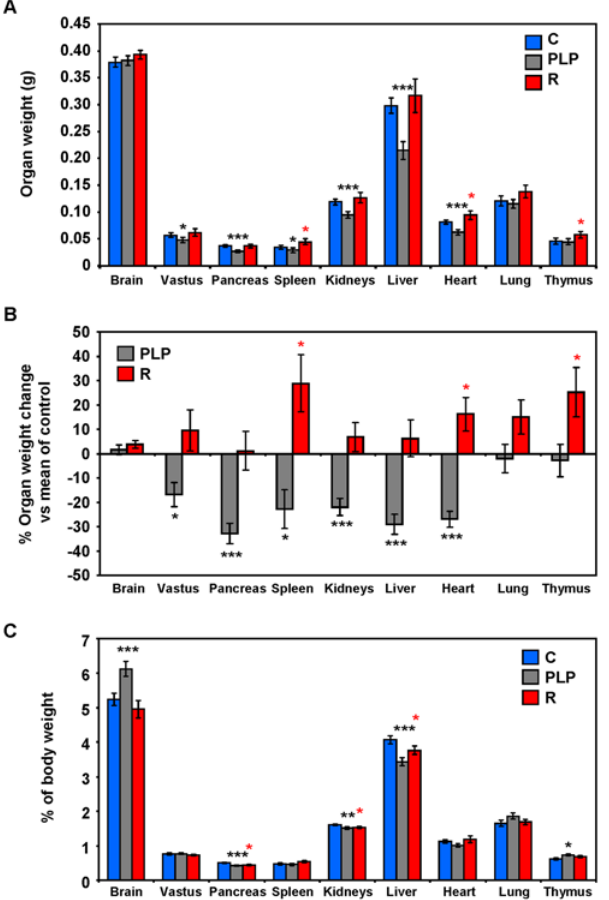
Figure 2. Effects of maternal protein restriction on organ weights. Organ weights were measured 21 days after birth. (A) Organ weights were expressed as mean 6 SEM (* P , 0.05, ** P , 0.01, *** P , 0.001 compared to control; n=control (C): 10, postnatal low protein (PLP): 8, recuperated (R): 10). (B) Percentage organ weight change of PLP and R mice compared to the mean of control organ